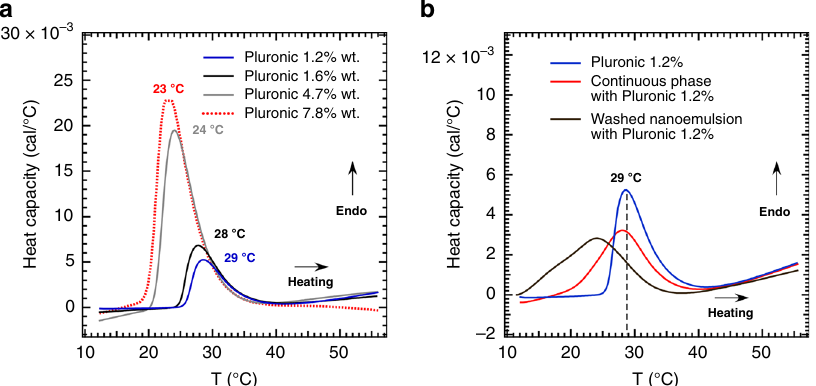
Fig. 3 Micro-DSC signals after baseline subtraction. DSC traces of, a aqueous solutions of F127/F68 (6/1 g/g) at different copolymer concentrations, b of Pluronic solution, the washed nanoemulsion (oil 0.4% wt.), and the subnatant solution (continuous phase) with a similar Pluronic concentration of 1.2%. Nanoemulsion suspensions were centrifuged to fi lter oil droplets (supernatant) from aqueous phase (subnatant) before adding Pluronic solution. The dashed line in b marks the endothermic peak for the 1.2% Pluronic